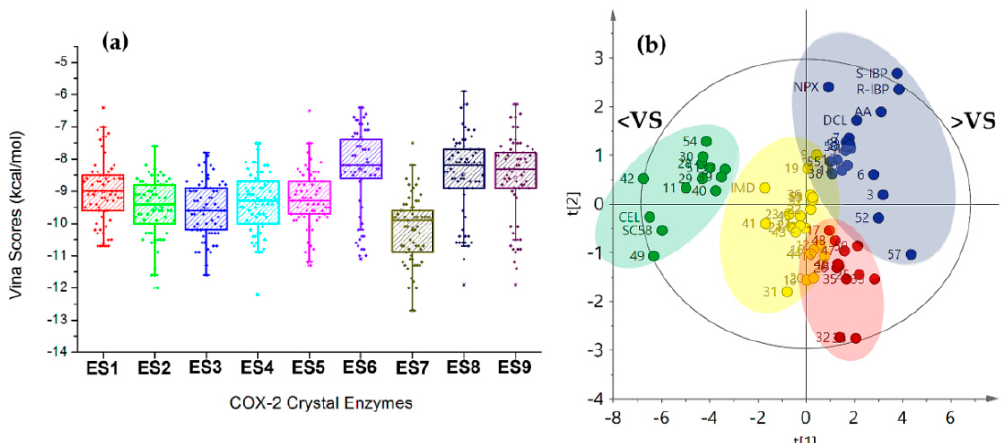
Figure 4. ( a ) Boxplot from Vina scores after docking between 2-arylbenzofuran-related compounds and nine crystal structures of COX-2. ( b ) Score plot from Principal Components Analysis (PCA) on Vina scores after docking of test compounds with COX-2 structures. Clustering: green (group 1), dark blue (group 2), Yellow (group 3), and red (Group 4). <VS = lowest Vina Scores. >VS = Highest Vina Scores.